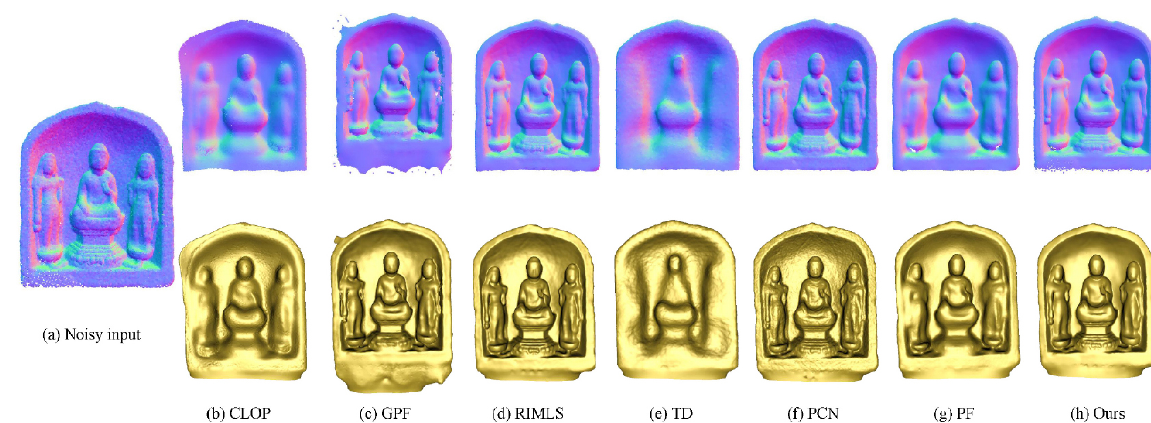
Fig. 9 Upsampling results on the Nefertiti raw scanned model.